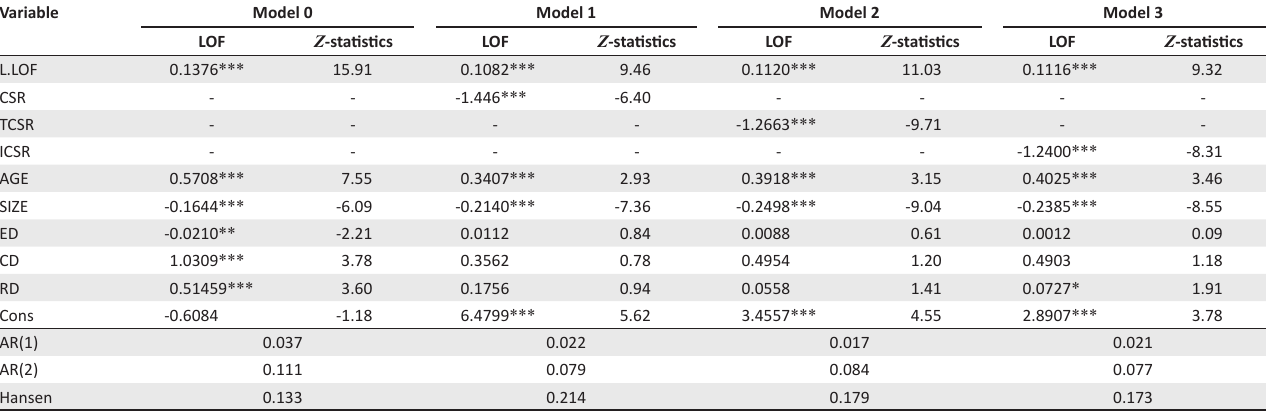
TABLE 2: Impact of corporate social responsibility and its components on liability of foreignness. Variable